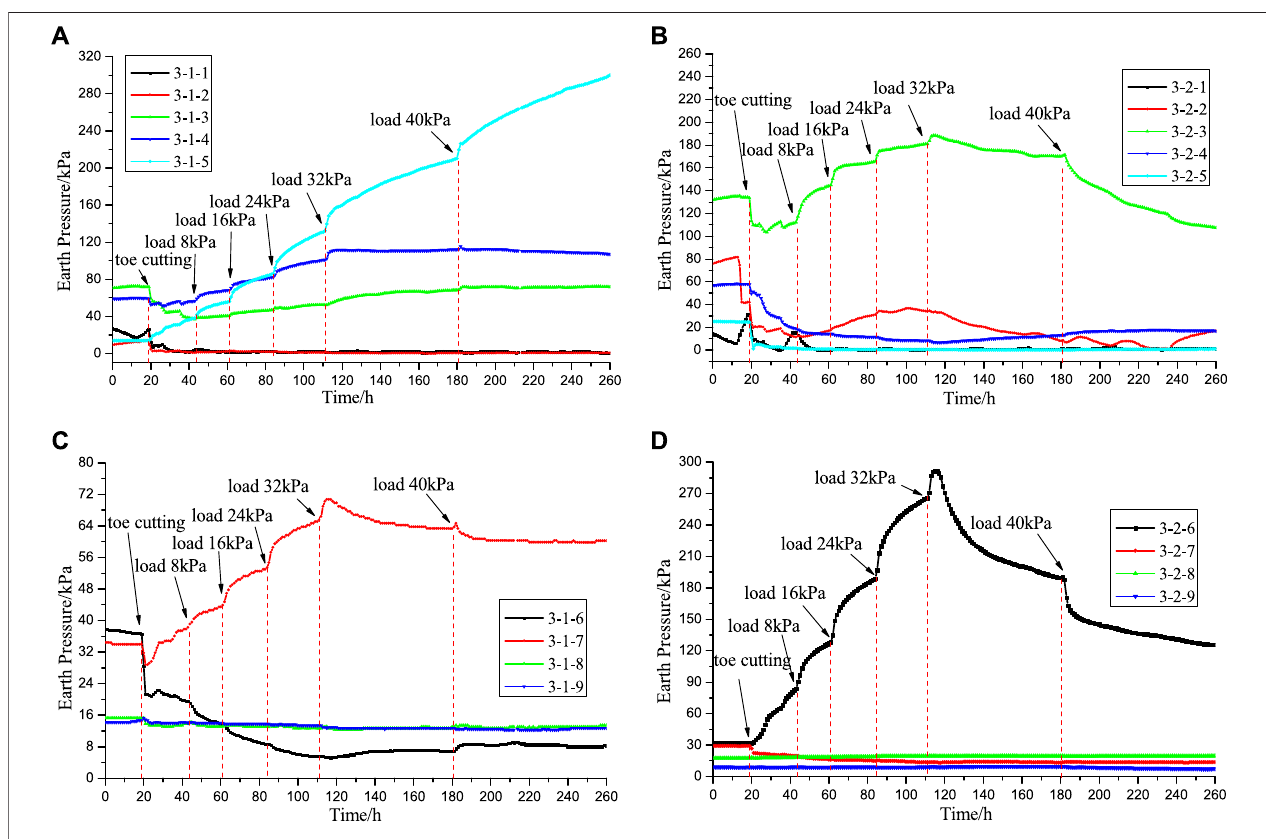
FIGURE11| Earthpressuremeasured in frontofand behindpileS4: (A) earth pressureinfront oftheanti-slidingsegmentofpileS4, (B) earthpressurebehind the anti-sliding segment of pile S4, (C) earth pressure in front of the anchoring segment of pile S4, and (D) earth pressure behind the anchoring segment of the pile S4.